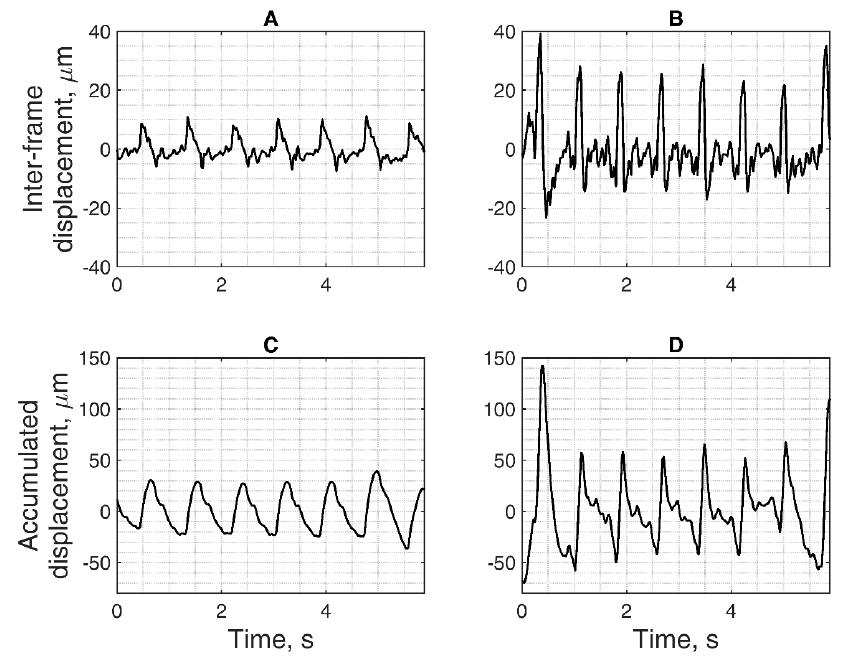
Figure 8. Hippocampus region-averaged displacements signals: ( A , B ) inter-frame displacements of the hippocampus; ( C , D ) accumulated displacements of the hippocampus. Parts ( A , C ) correspond to the subject with Alzheimer’s disease, parts ( B , D ) to the healthy elderly subject.